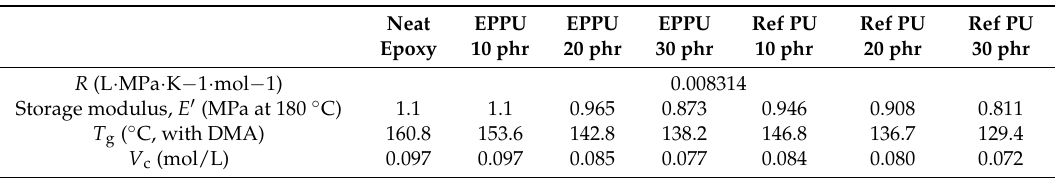
Table 4. Storage moduli and V c of epoxy compositions containing PUs. phr: parts per hundred resin; DMA: dynamic mechanical analysis.